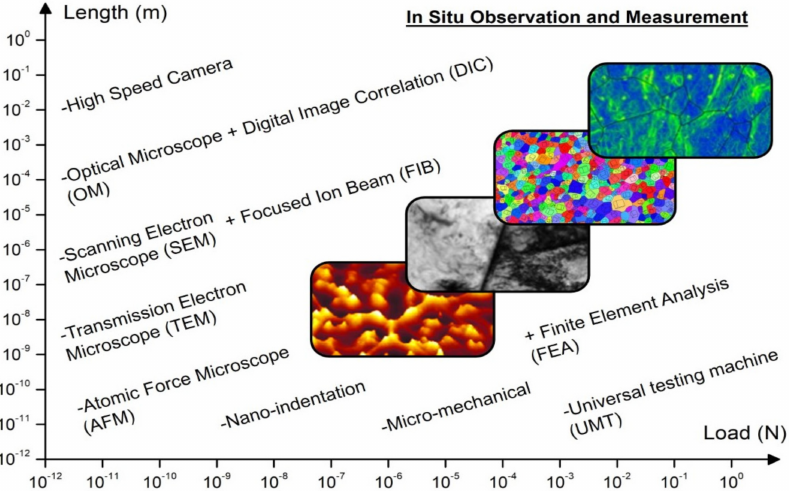
Figure 1. Schematic representation of the key tools and techniques utilized for the in situ characteri- zation of materials at different length and force measurement